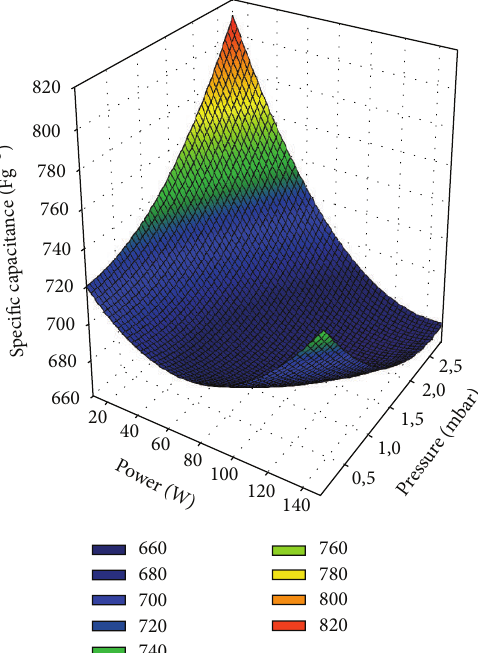
Figure 6: 3-dimensional graph of the specific capacitance of water plasma-treatedCNTs/MnO 2 electrodeswithrespecttorf-powerand water